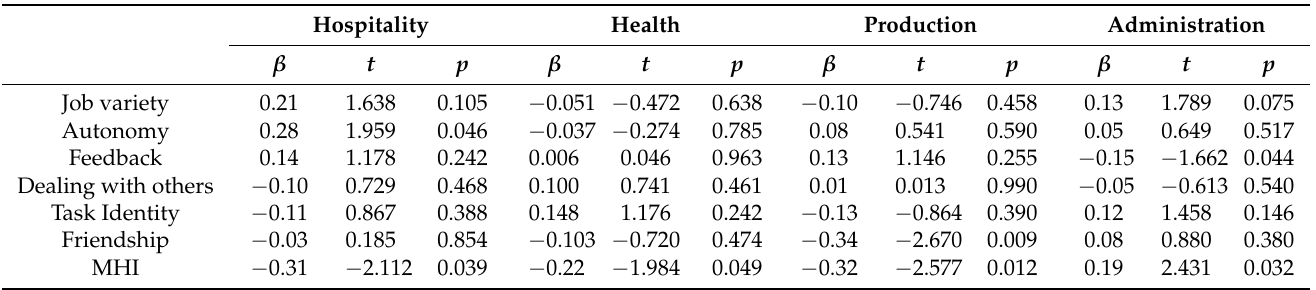
Table 4. The prediction of absenteeism in the context of job characteristics and mental health among different sectors.